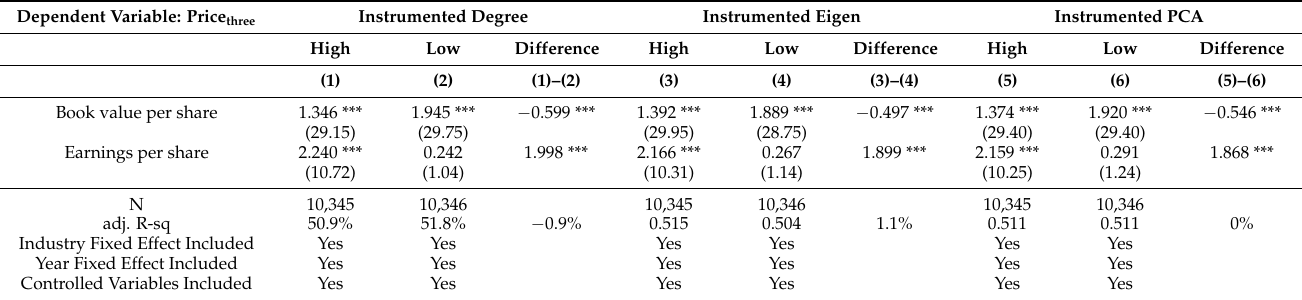
Table 8. Instrumented CEO social capital and the value relevance of accounting metrics. This table presents the second-stage results explaining the effect of instrumented CEO social capital on the value relevance of book value of equity and earnings metrics, using the instrumental variable method. The dependent variable is Price three , a continuous variable measured by the market price of the common equity at the end of three months after fiscal year-end. Instrumented CEO social capital is measured by Instrumented Degree in columns (1) and (2), Instrumented Eigen in columns (3) and (4) and Instrumented PCA in columns (5) and (6). Variables of interest in the regression include Book value per share (book value of common equity per share) and Earnings per share (net income per share). All regressions include control variables as defined in Appendix A. For brevity, the table only presents coefficients related to the variables of interest. All regressions include time- and industry-fixed effects and the errors are robust to firm heteroscedasticity. T-values are reported in parentheses. Statistical significance of the coefficients is designated as *** at 1%